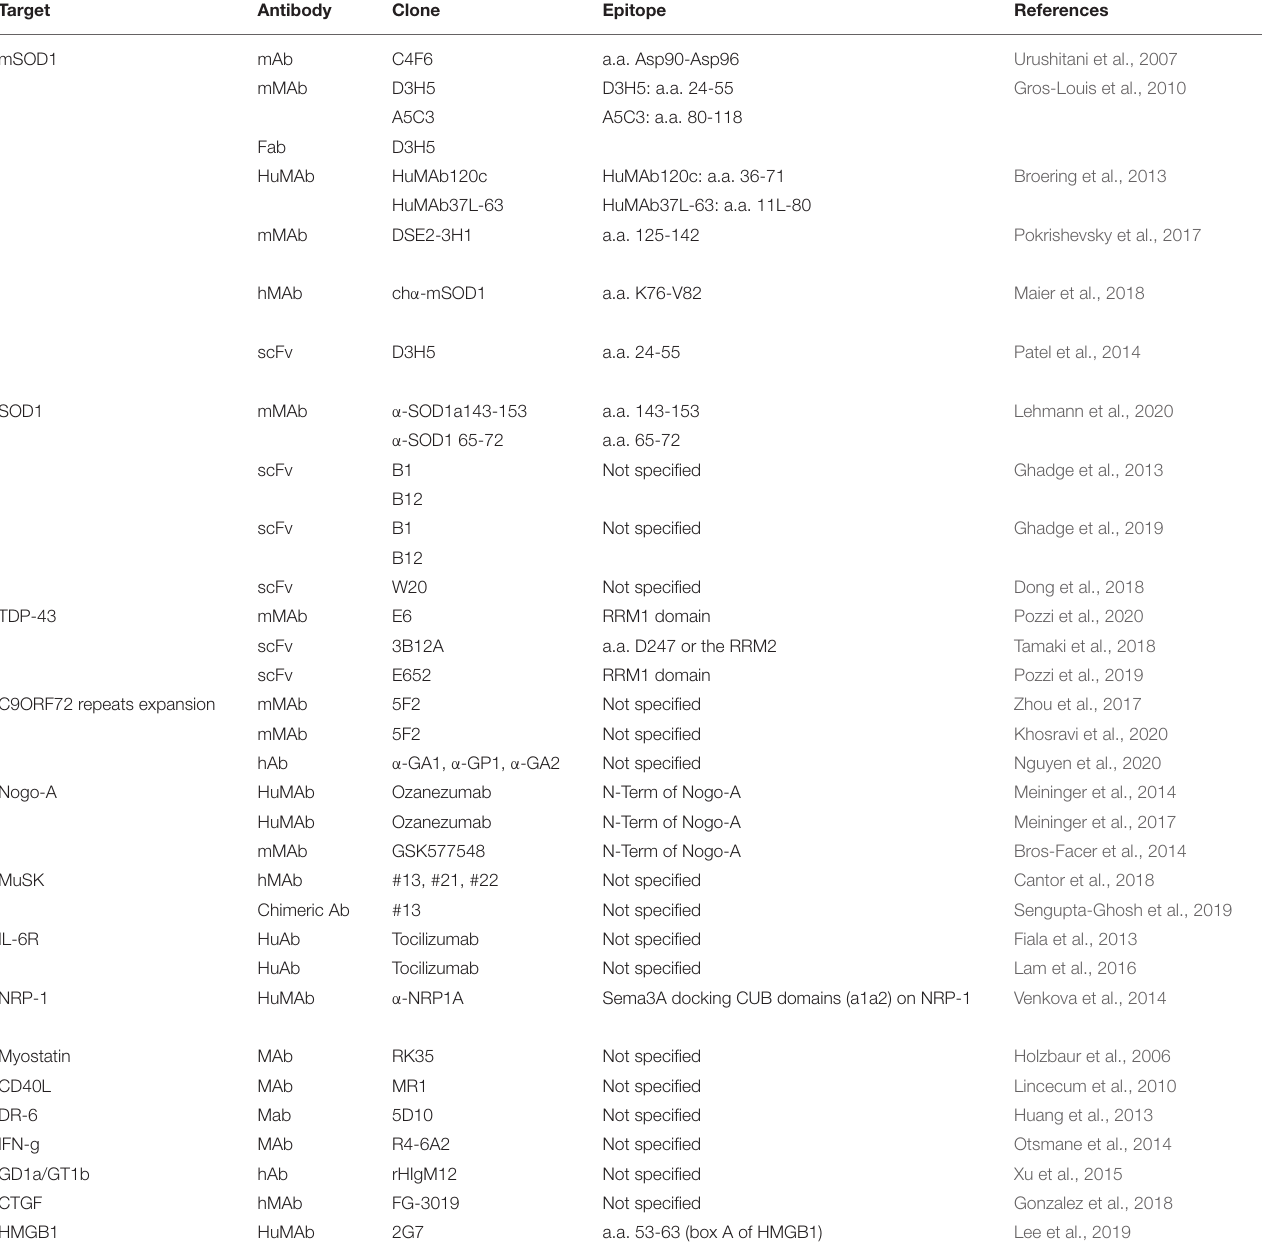
TABLE 1 | Summary of the main characteristics of the antibody-based interventions identified in the 31 original articles analyzed in this